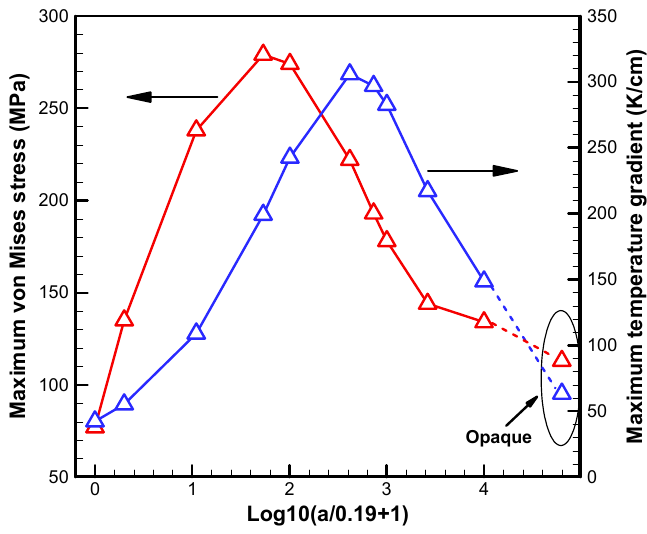
Figure 7. Maximum temperature gradient and thermal stress at the bottom of crystal with different coefficient absorptions.